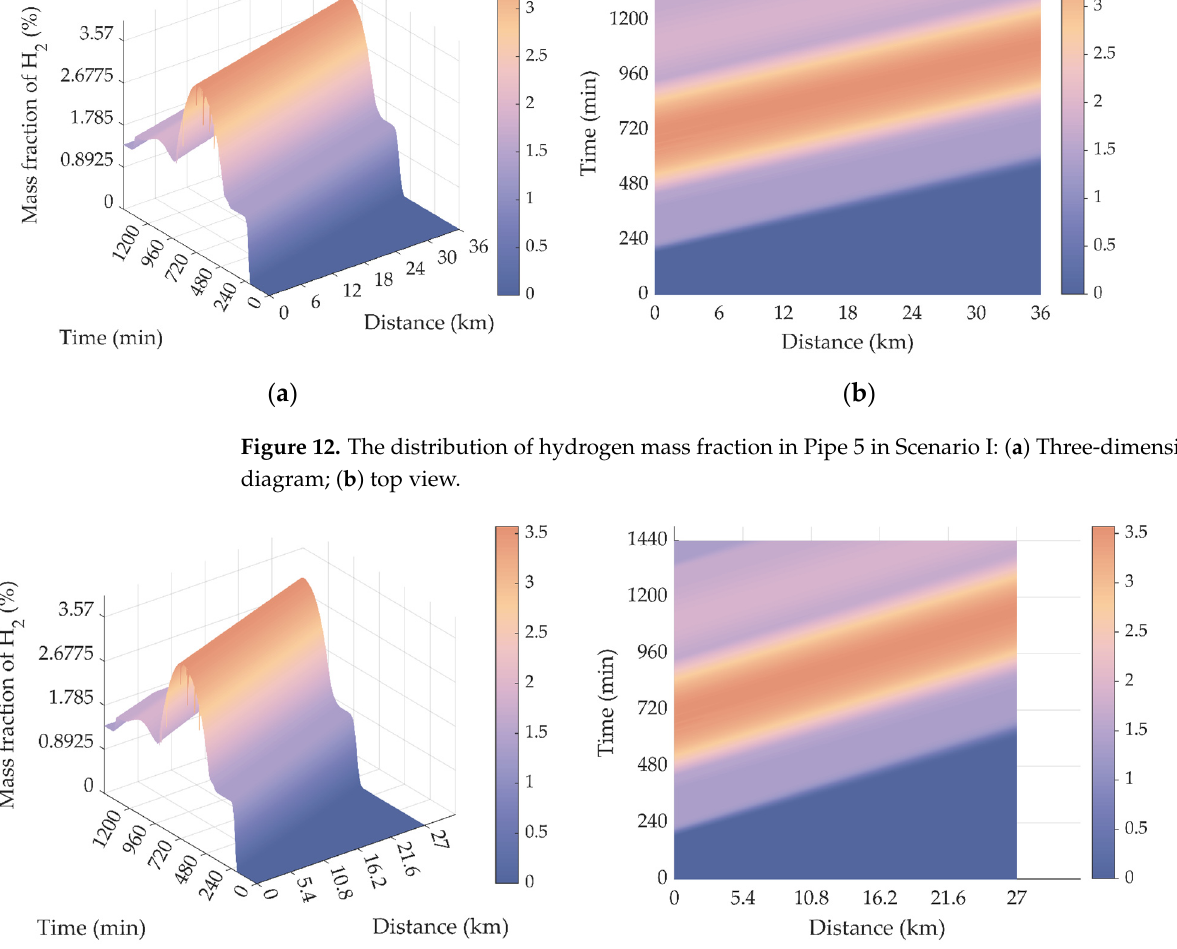
Figure 13. The distribution of hydrogen mass fraction in Pipe 6 in Scenario I: ( a ) Three-dimensional diagram; ( b ) top view.